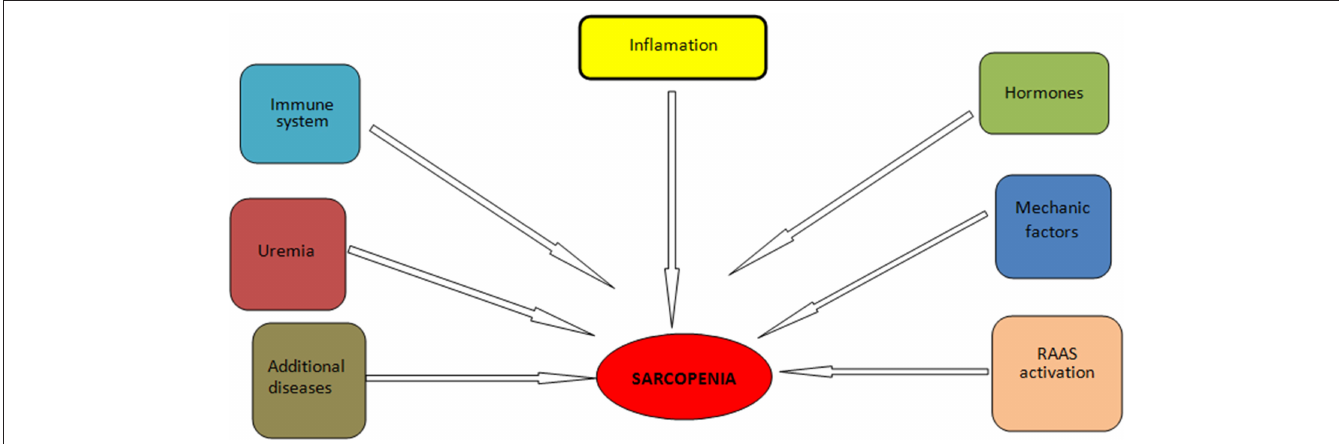
Figure 2. Potential sarcopenia mechanisms in